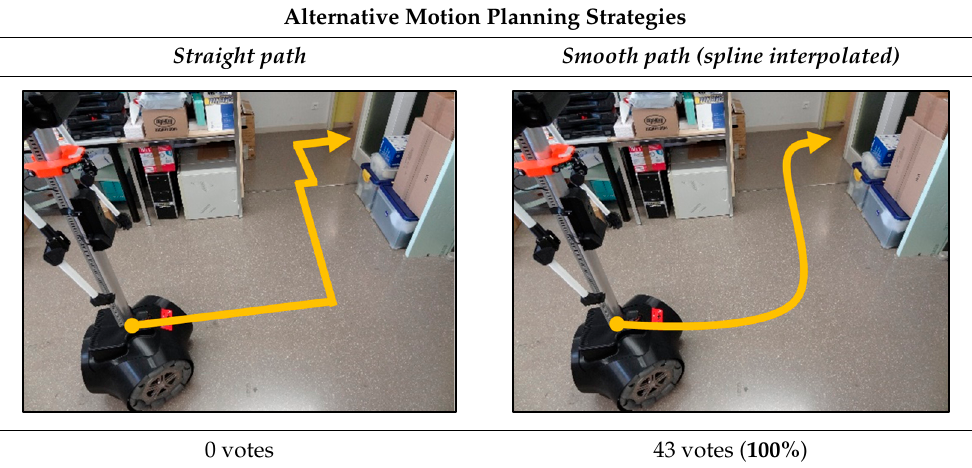
Table 11. Alternatives considered to implement the motion planning strategy and votes received.